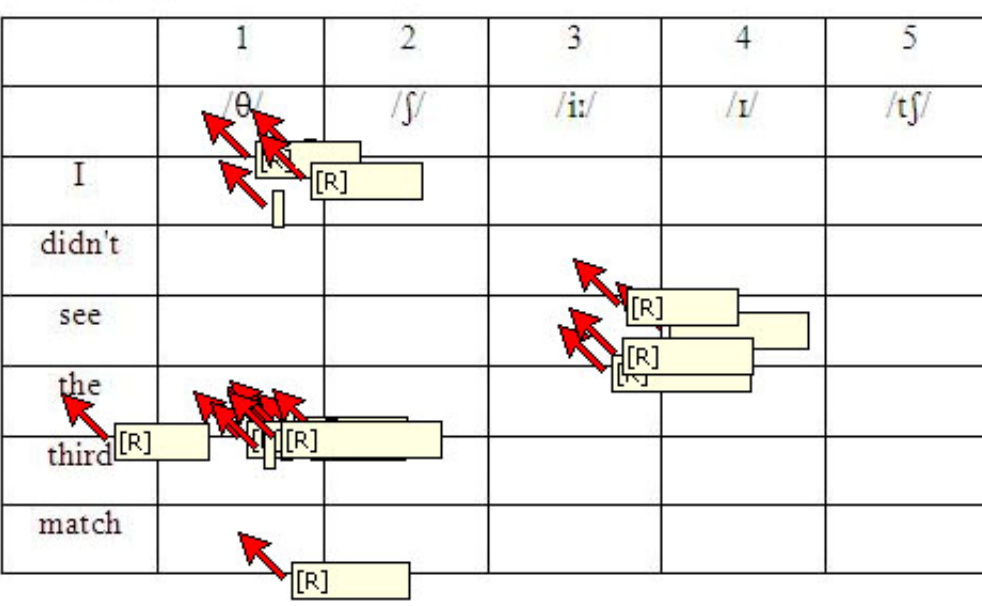
Figure 10 . Using IPA symbols on the whiteboard (names removed from